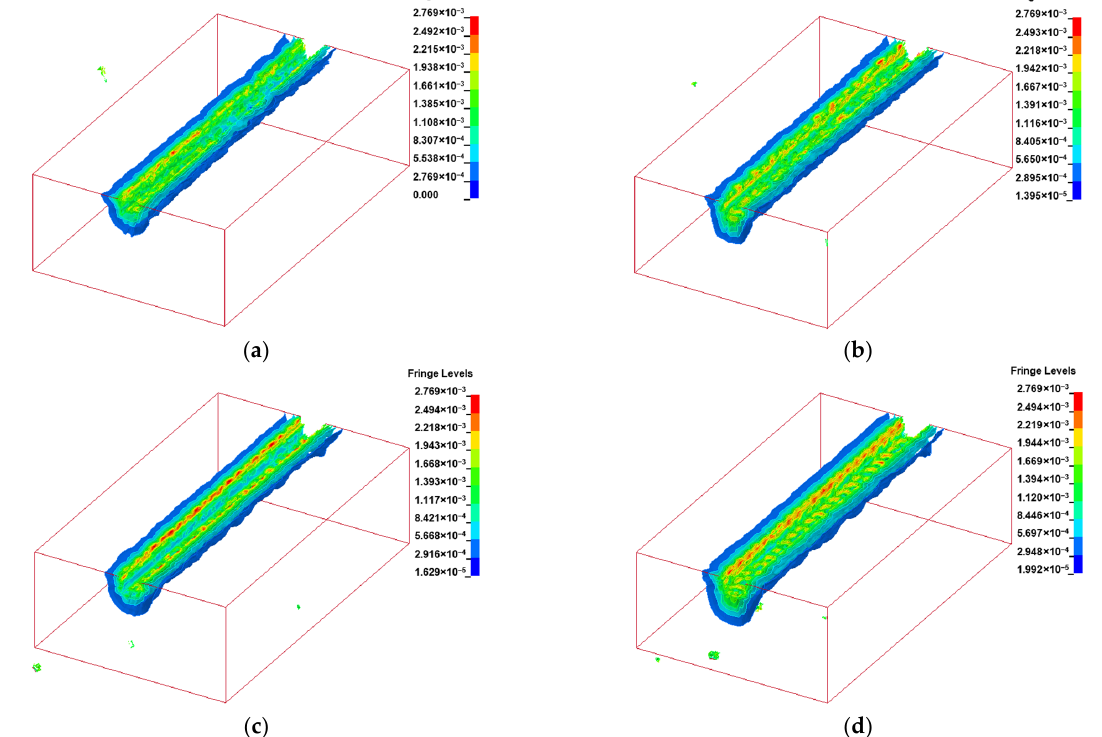
Figure 20. Equivalent stress isosurface of rock breaking using disc cutter with 5 mm blade fillet. ( a ) Isosurface of equivalent stress (Blade width 19 mm); ( b ) Isosurface of equivalent stress (Blade width 22 mm); ( c ) Isosurface of equivalent stress (Blade width 25 mm); ( d ) Isosurface of equivalent stress (Blade width 28 mm).